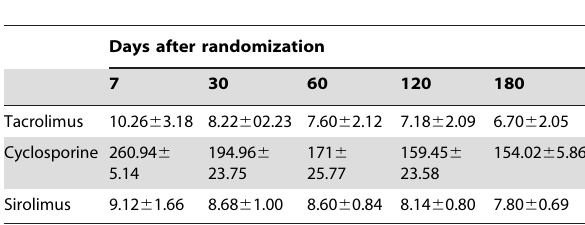
Table 2. Calcineurin inhibitor and Sirolimus trough levels at different time